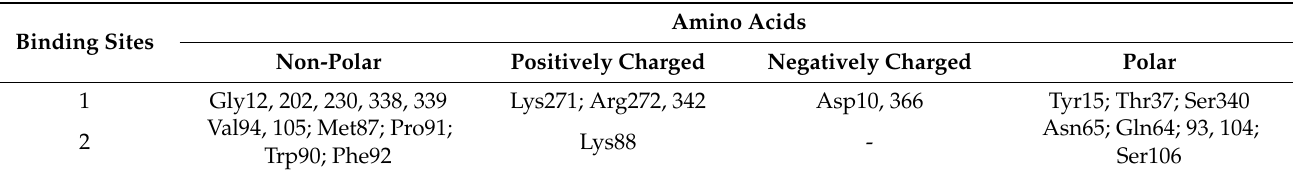
The characteristics of amino acids that compose the microenvironment of Sites 1 and 2 obtained by molecular docking.